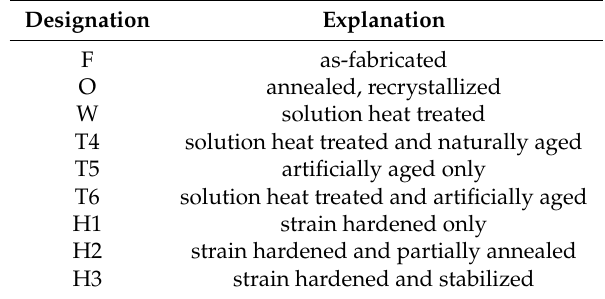
Table A2. Common temper designations based on Reference